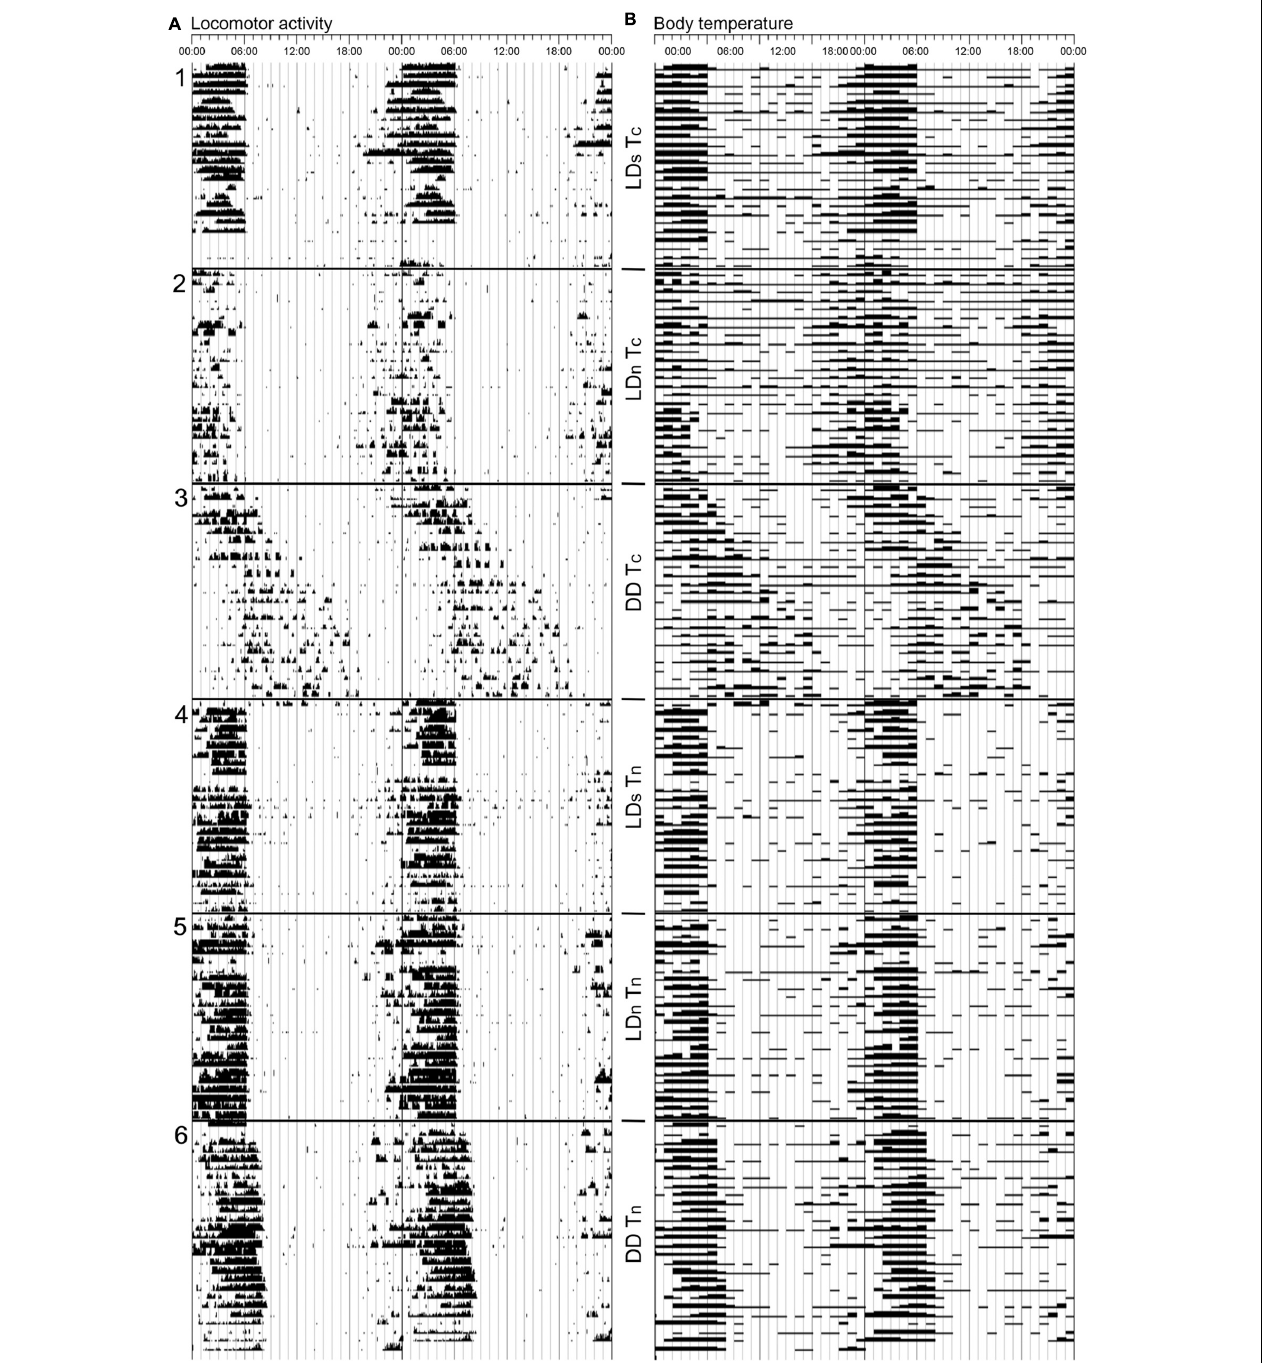
FIGURE 3 | An example of actograms for (A) locomotor activity and (B) body temperature of a Mahali mole-rat ( Cryptomys hottentotus mahali ) that was subjected to six consecutive light and temperature regimes. The light cycle order was a square wave cycle (12L:12D), simulated dawn and dusk natural cycle (1 h each, 12 h complete darkness) and DD, repeated twice (cycles 1–3, and 4–6). The first three cycles (1–3) had a constant ambient temperature of 25 ◦ C, and the last three (4–6) were subjected to a temperature cycle varying between 18 and 28 ◦ C over 24 h. The actograms show the close relationship between locomotor activity and body temperature. Cycles 4–6 show more robust rhythmicity, implying the supportive role of ambient temperature to entrainment. A comparison between the DD cycles shows free-running under constant ambient temperature (cycle 3) while activity remains entrained but slightly shifted with a temperature cycle (cycle 6). Actograms are double plotted with the time on the X -axis. The number of days is on the Y -axis and the experimental conditions are illustrated between the two actograms. LD s , square wave; LD n , natural wave; T c , constant ambient temperature; T n , natural ambient temperature cycle. (Modified from Van Jaarsveld et al., 2019, with permission from Elsevier).